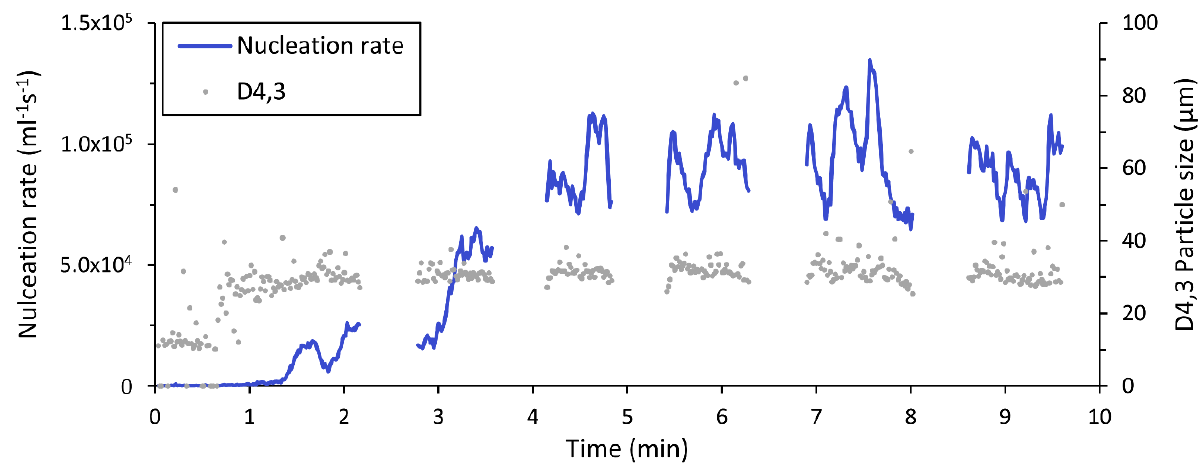
Figure 3. Nucleation rate and particle size over time after starting sonication (at time 0), (residence time = 2.6 s).